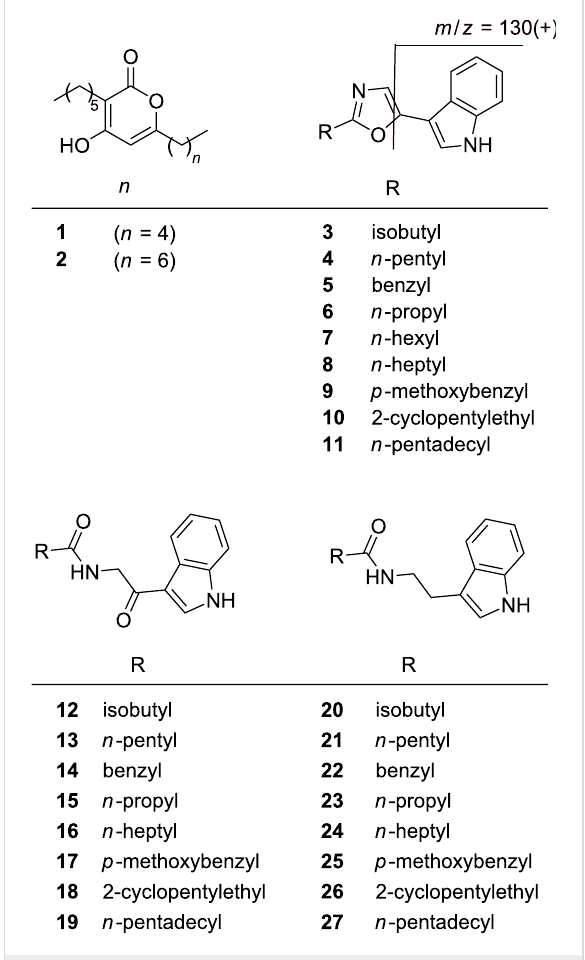
Figure 1: Structures of pseudopyronines A ( 1 ) and B ( 2 ) and natural oxazoles ( 3 – 8 ) as well as synthetic oxazole derivatives ( 9 – 11 ). All natural and synthetic oxazoles show the characteristic MS fragment 130 m / z [M + H] + . The intermediates of the oxazole syntheses ( 12 – 27 ) are also shown as they were also tested for their biological